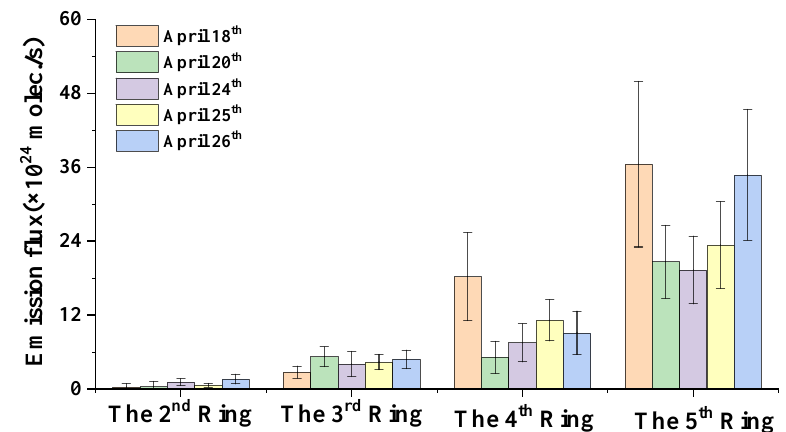
Figure 8. The NO X emission flux and its error for the ring roads in Beijing; measurements taken on April 18th, 20th, 24th, 25th, and 26th, 2018.